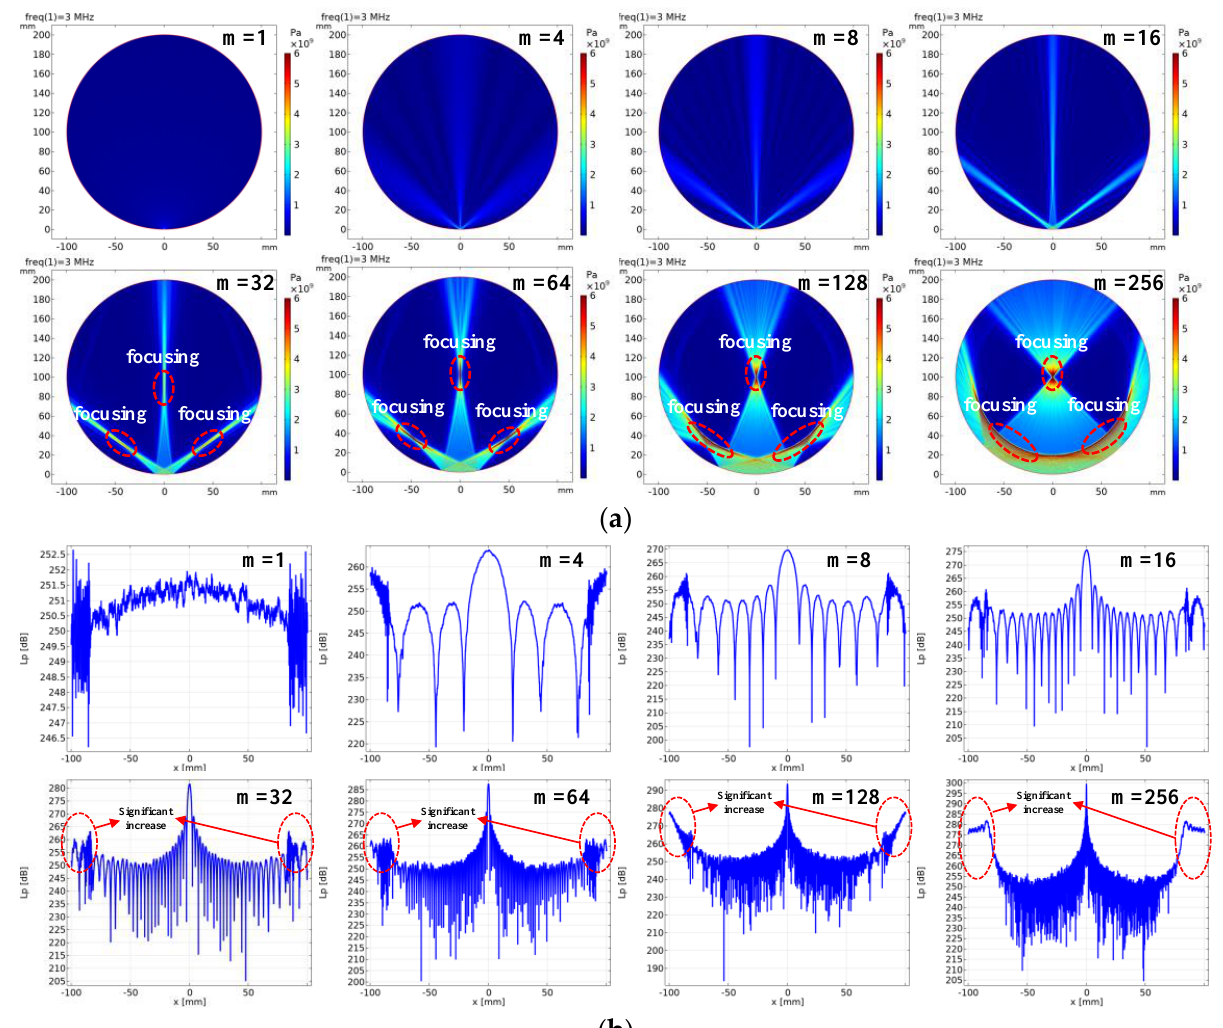
Figure 4. Acoustic field pattern and beam directivity pattern of the different number of active elements in the ring array (m = 1, 4, 8, 16, 32, 64, 128, 256). ( a ) Acoustic field distribution results formed by the different number of active elements. ( b ) Calculation results of the beam direction formed by the different number of active elements in the ring array.